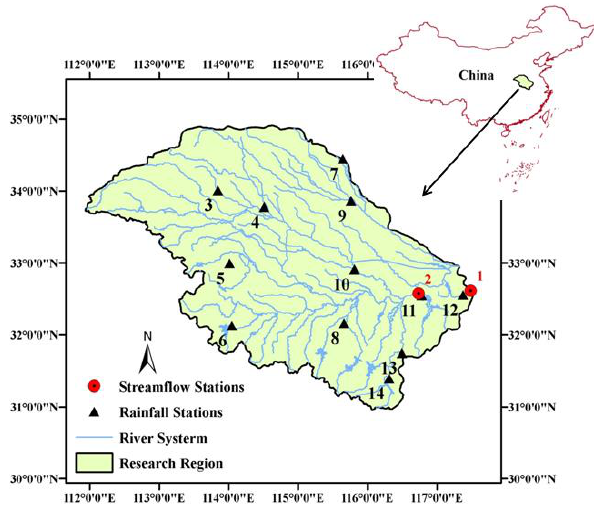
Fig. 1. Location of the study Figure1: Location of the study area. 566